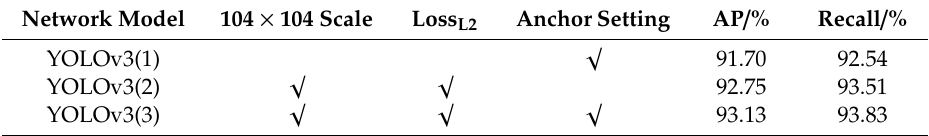
Table 6. Performance comparison of each part of the improved model on the MyShip dataset.